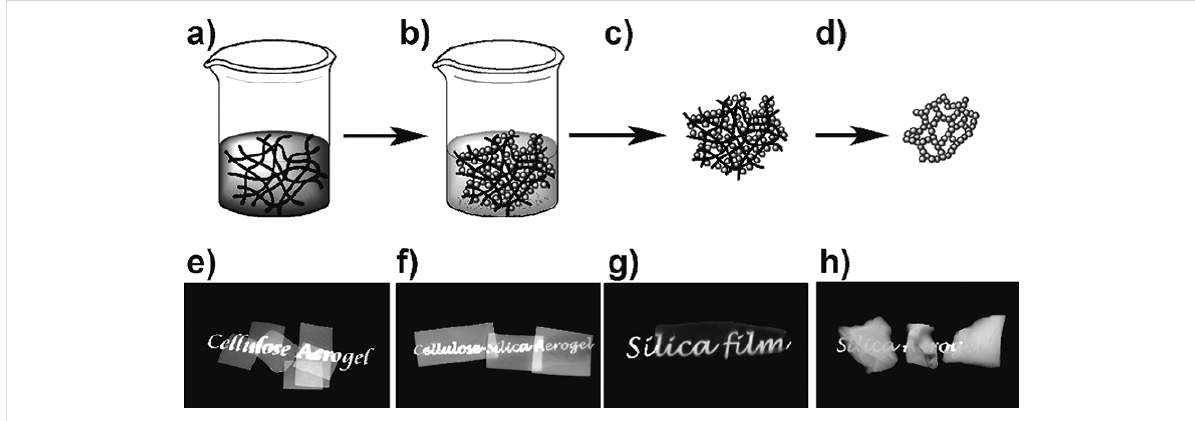
Figure 8: Schematic representation of aerogel preparation. A nanoporous cellulose gel is impregnated with the silica precursor TEOS (a). Afterwards, the silica formation takes place by sol–gel process (hydrolysis and condensation), yielding a cellulose–silica composite gel (b). Drying with